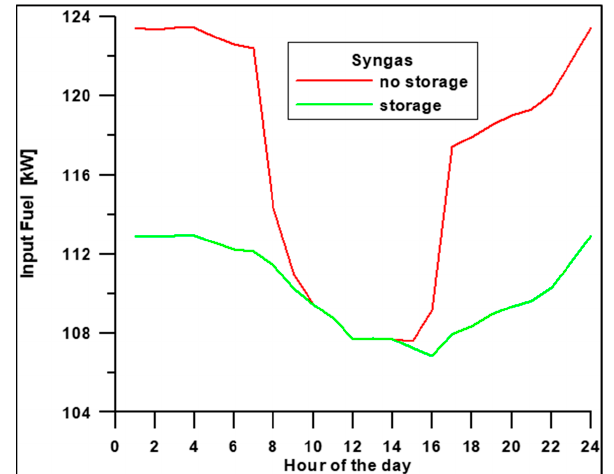
Figure 4. Efficiency versus day hours (Syngas fuel). Figure 4. E